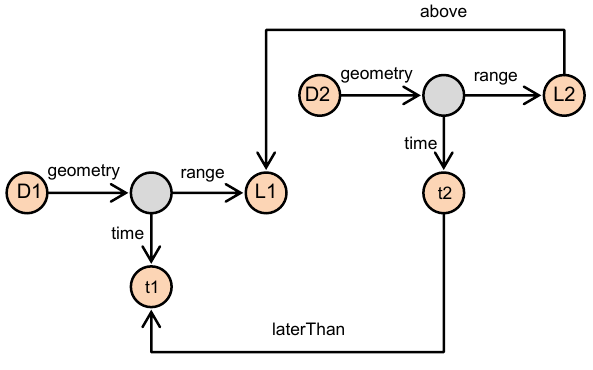
Figure 3. Pattern for stratigraphic